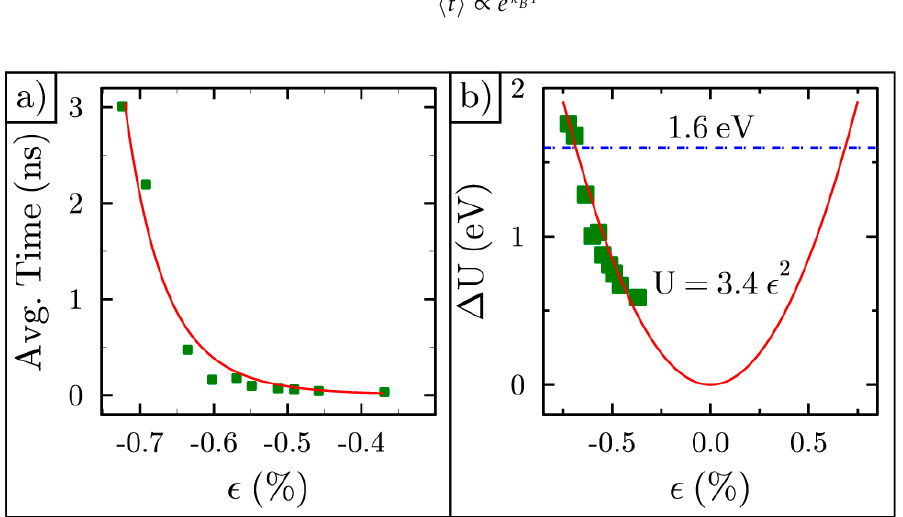
Figure 4. Average time and energy barrier: ( a ) Average time between curvature inversion vs. strain; ( b ) Barrier height vs. strain.